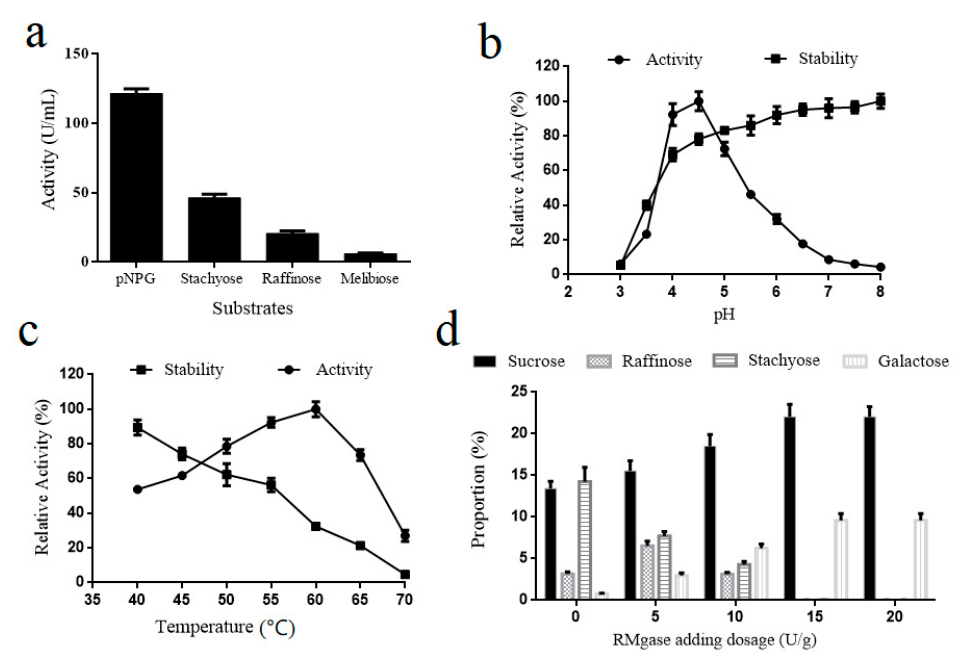
Figure 1. ( a ) RMgase activity based on different substrates. ( b ) Effect of different pH values on the activity and stability of the purified enzyme. ( c ) Effect of different temperatures on the activity and stability of the purified enzyme. ( d ) Effects of the amount of RMgase addition on sucrose recovery from soy molasses. Data are given as means ± standard deviation, n = 3 (b, c, d).